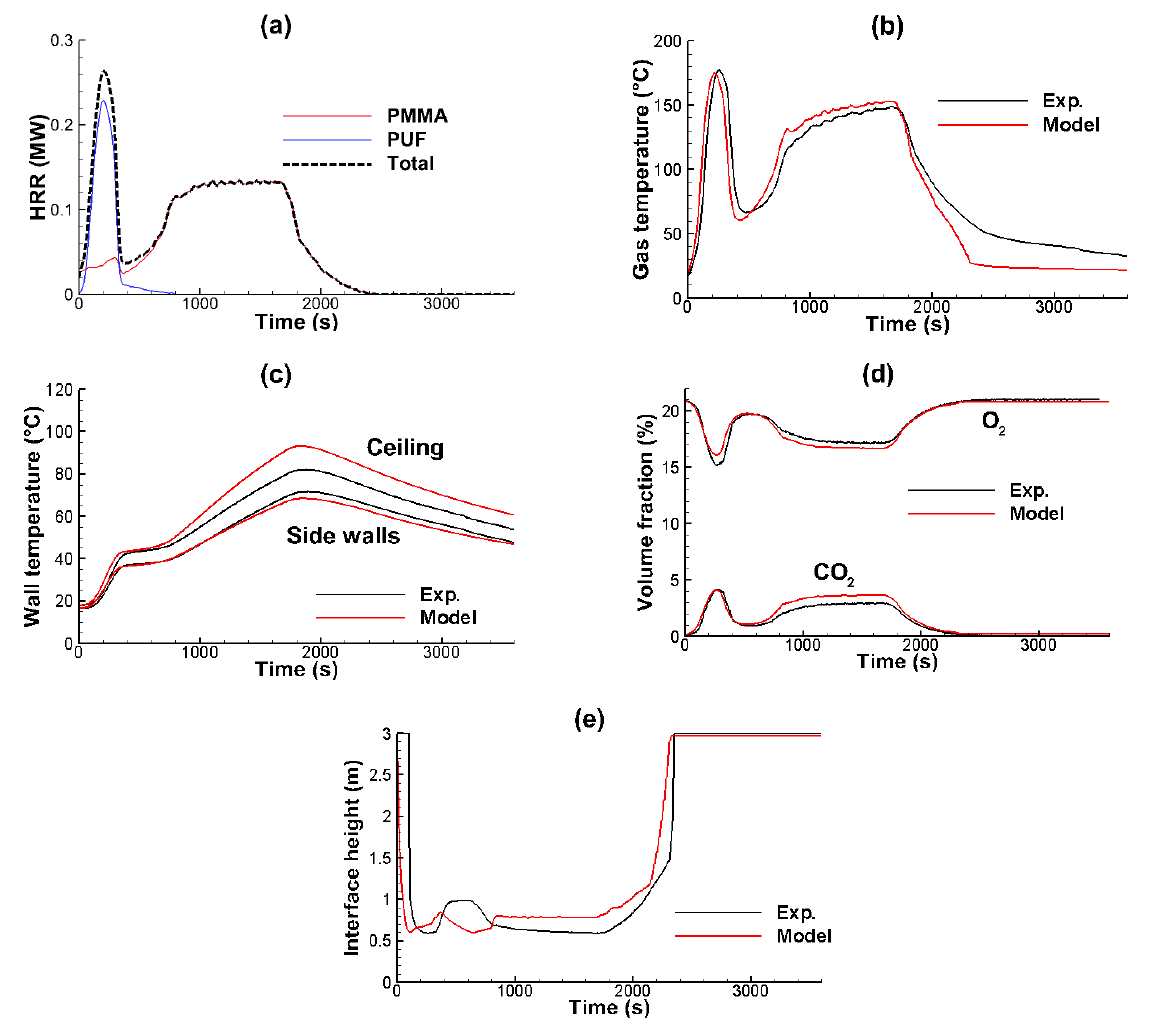
Figure 10. Test 2: ( a ) individual and total HRRs, ( b ) average gas temperature, ( c ) average wall temperatures, ( d ) volume fractions of O 2 and CO 2 in the exhausted gases, and ( e ) smoke layer interface height.